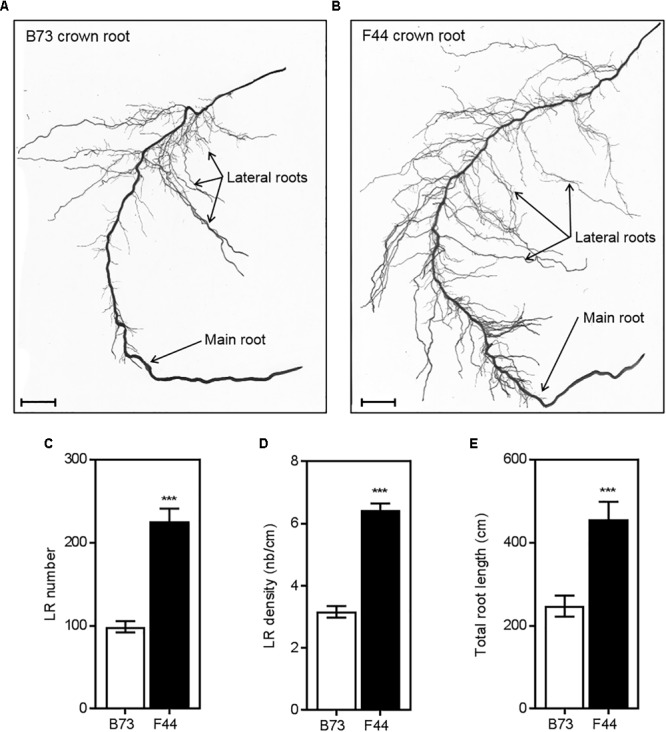
Comparison of crown root architecture of B73 (A) and F44 (B) maize inbreds. Measurements of lateral root numbers (C), lateral root densities (D) and total root lengths (E) of B73 (white) and F44 (black) crown roots. Values are means (±SE) from five individual plants. Similar results were obtained in another independent experiment. Scale bars = 25 mm. Asterisks indicate significant differences between lines at ∗∗∗P < 0.005 (Student’s t-test).